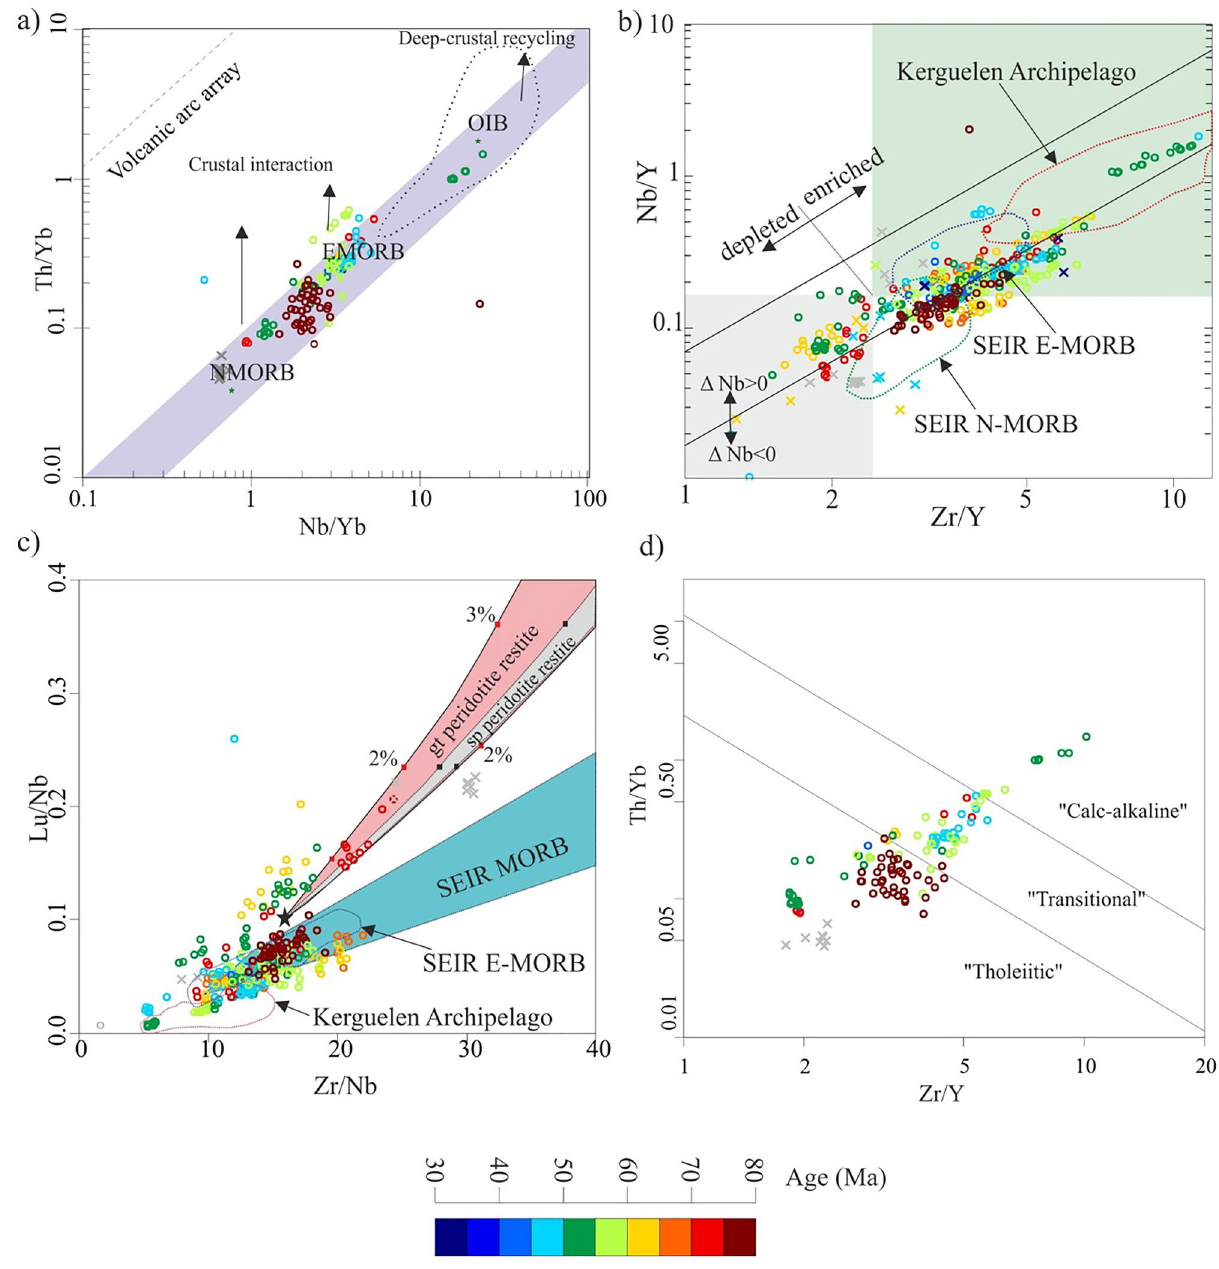
Figure 3. Non-subducting MORB-OIB arrays. ( a ) Th/Yb vs. Nb/Yb 57 to discriminate between MORB–OIB, and volcanic arc arrays. The NER basalts are enriched basalts, with less crustal interaction, except perhaps for ca. 55 Ma basalts, which encountered extensive deep crustal recycling. ( b ) Nb/Y vs. Zr/Y array 58,66 is used to distinguish between enriched/depleted Iceland basalt, and the Atlantic MORB; the NER basement rocks are similar to the Icelandic basalts 54 with Δ Nb > 0. ( c ) Garnet/clinopyroxene Lu/Nb vs. Zr/Nb sensitive ratios 55 ; melting trajectories based on Zou 68 equations, and calculated supposing 2% porosity 55 . ( d ) Th/Yb vs. Zr/Y immobile elements discrimination diagram to determine the magma type 59 . Colored circles are the NER basalts, assigned to their ages based on the colored ages bar; the colored crosses are samples from the Chagos-Laccadive Ridge and the Mascarene Plateau, while grey crosses are not assigned to